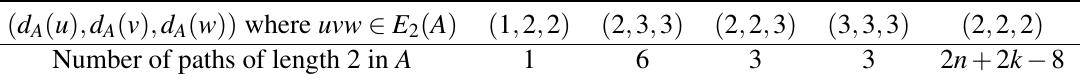
Table 6 Partition of paths of length 2 of the graph A = L ( S ( T n , k )) for k >